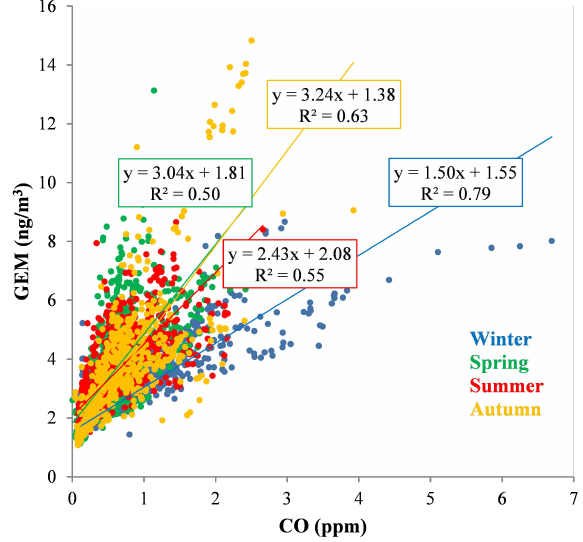
Fig. 6. Correlation between CO concentration and GEM concentra- tion. Notes: The data were hourly averaged.